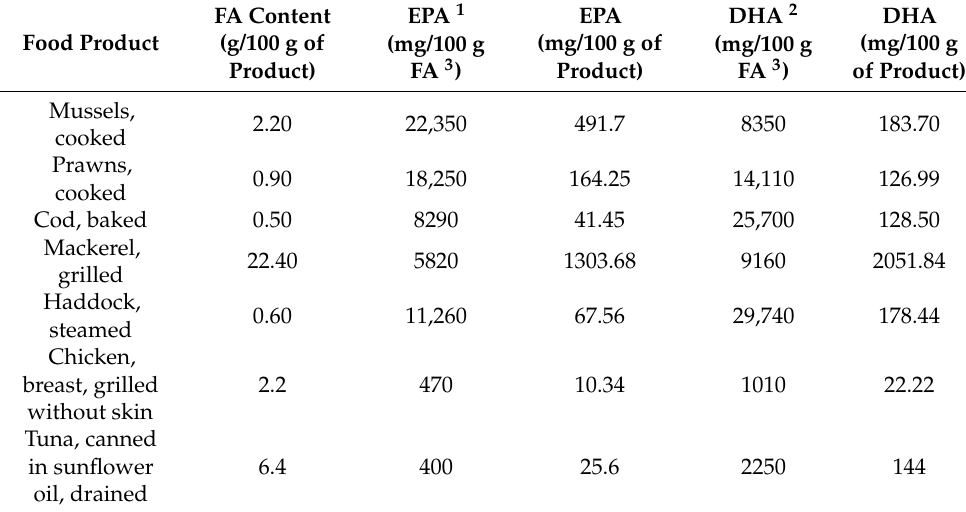
Table 1. Selected products with high DHA and EPA content